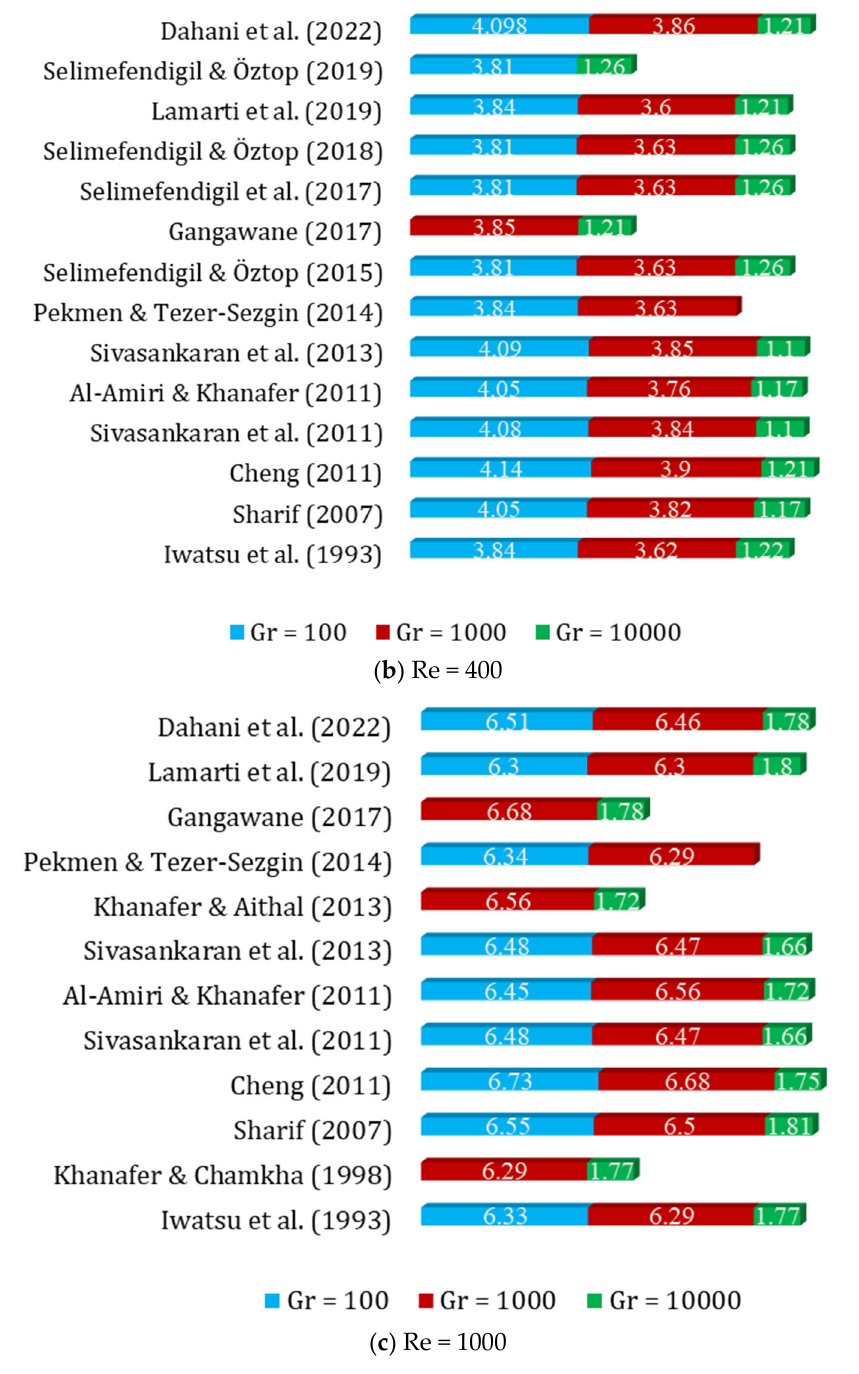
Figure 4. Variation of Nu avg with different Gr for Pr = 0.71 (Case: Mixed convection flow inside a square lid ‐ driven cavity) [31,33,34,53,55,93,105,106,124,139,142,188,189,207–211].